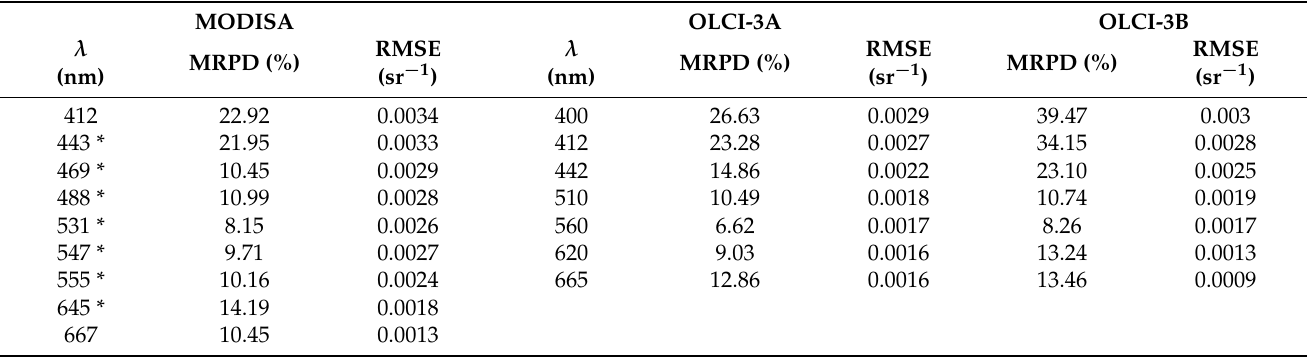
Figure 13. Validation of remote sensing reflectance ( R rs ) derived from ( a ) MODIS/Aqua (MODISA), ( b ) OLCI/Sentinel-3A (OLCI-3A), ( c ) OLCI/Sentinel-3B (OLCI-3B) and ( d ) aerosol optical depth at 865 nm, τ(865) , with in situ data measured by SeaPRISMs at the Muping and Dong’ou site, respectively. Table 5. The median relative percentage difference (MRPD) and root mean square error (RMSE) of remote sensing reflectance ( R rs ) in the visible bands between SeaPRISM-measured and MODIS- or OLCI-derived data at the Muping and Dong’ou sites. * indicates the bands where the shifting scheme developed by Mélin and Sclep [41] was applied.